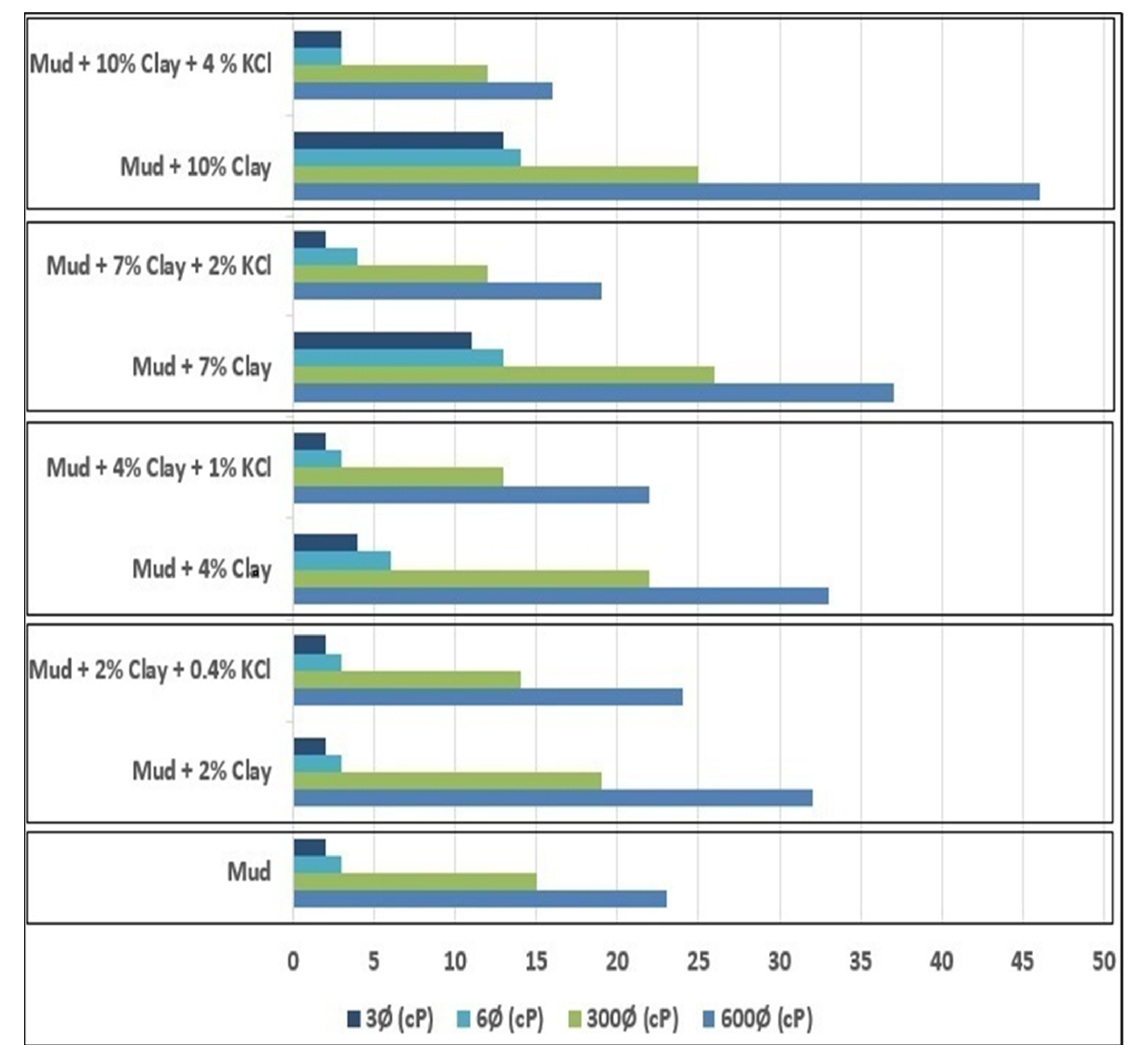
Figure 9. Correlation between all rheological dial readings ( x -axis) compared with formulated mud ( y -axis).